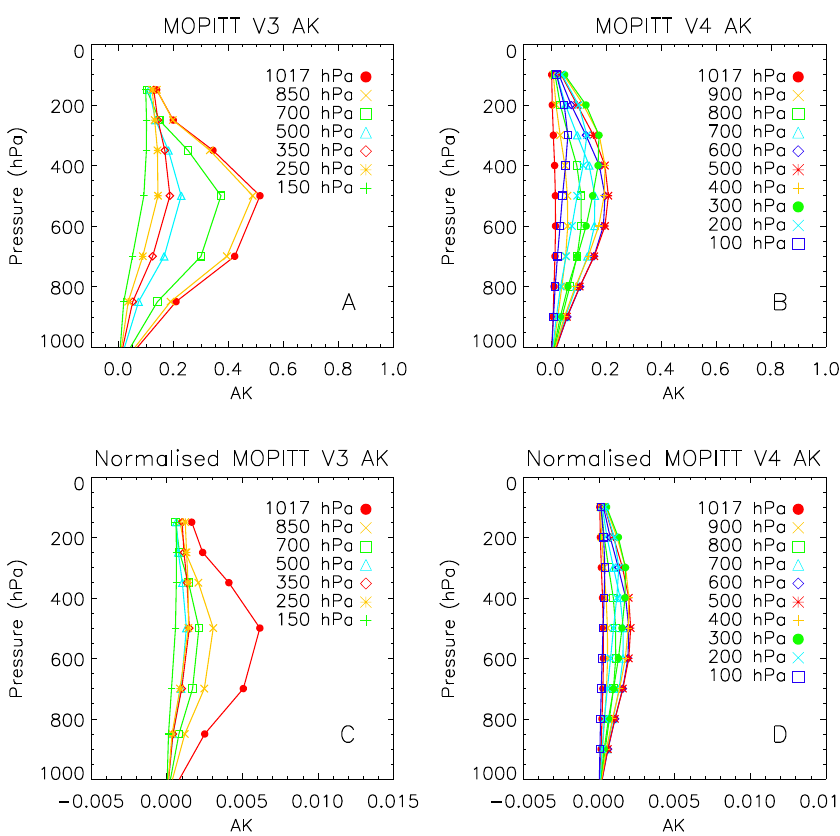
Fig. 2. Averaged daytime and ocean averaging kernels for 1 September 2007 over Southern Africa, for: (A) MOPITT V3 ( A MOP3 ), (B) MO- PITT V4 ( A MOP4 ), (C) pressure-layer-normalised averaging kernels for MOPITT V3 ( A MOP3 ), and (D) pressure-layer-normalised averaging kernels for MOPITT V4 ( A MOP4 ).The MOPITT V3 averaging kernels are in normal space, whereas the MOPITT V4 averaging kernels relate to log(VMR) values, and the units of the pressure-layer-normalised averaging kernels are hPa − 1 .